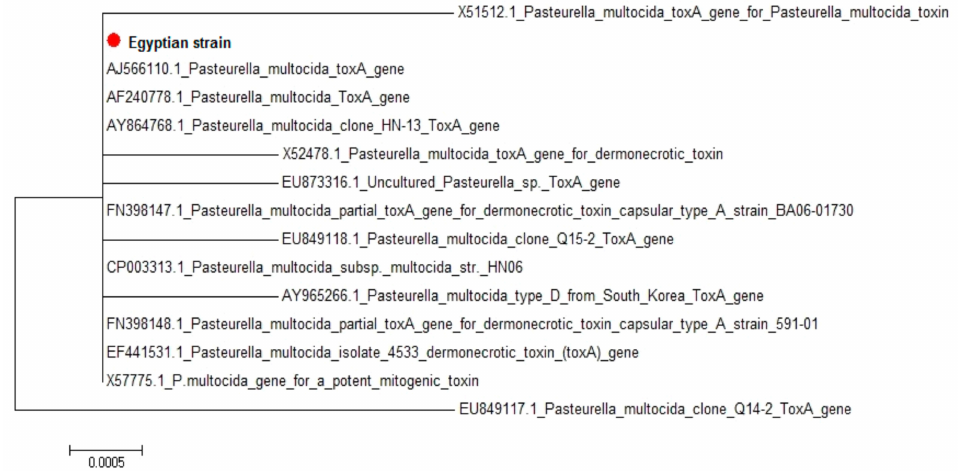
Figure 1. Phylogenetic tree for P. multocida serotype B:2 toxA showing clear clustering of the Egyptian strain with di ff erent strains uploaded in the gene bank.